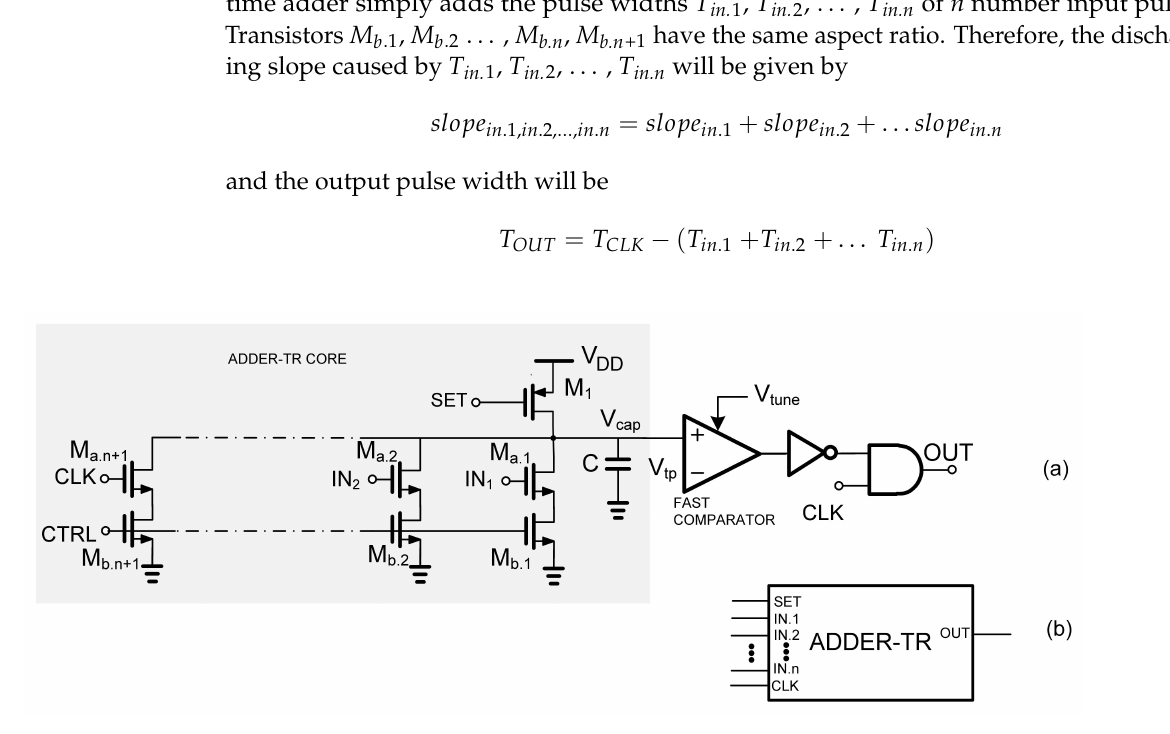
Figure 5. ( a ) Time adder based on time register and ( b )